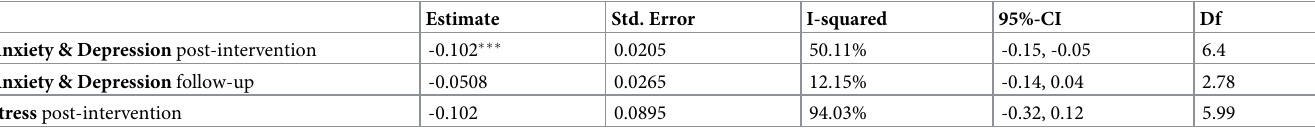
Table 2. RVE meta-analysis